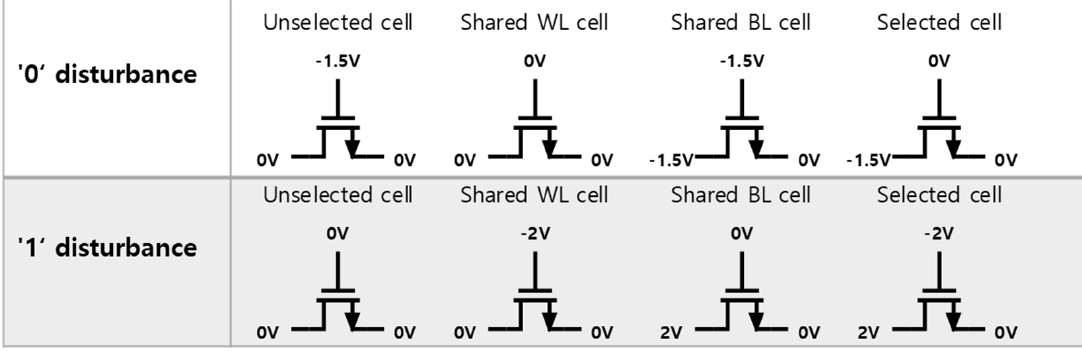
Figure 5. Voltage applied at each cell location depending on the type of disturbance in the first simulation.